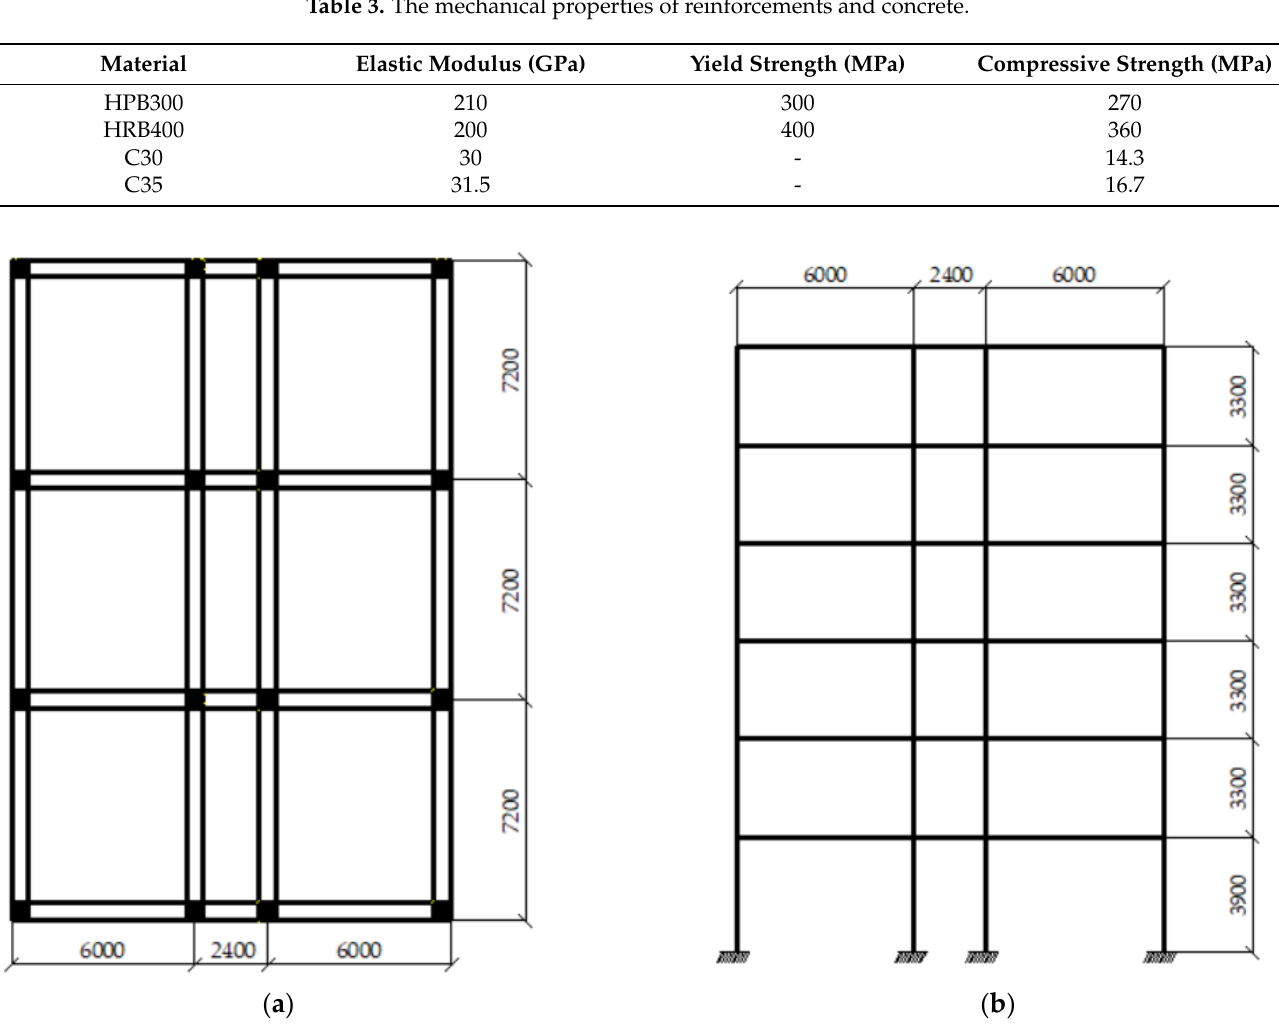
Figure 2. The arrangement of beams. Table 1. Sizes and reinforcement details of frame columns. Storey